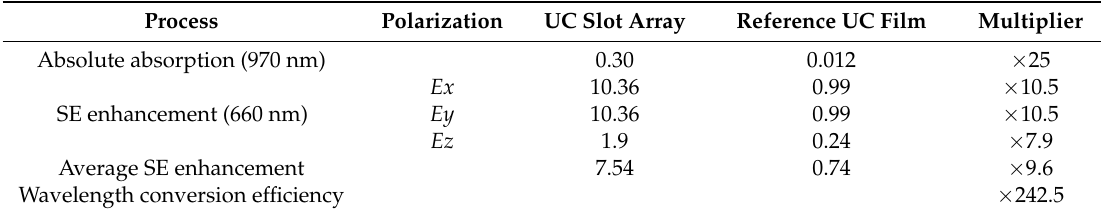
Table 1. Incident light (970 nm) absorption and spontaneous emission (SE, 660 nm) enhancement for the proposed upconversion (UC) slot array and 40-mm-thick reference UC film.